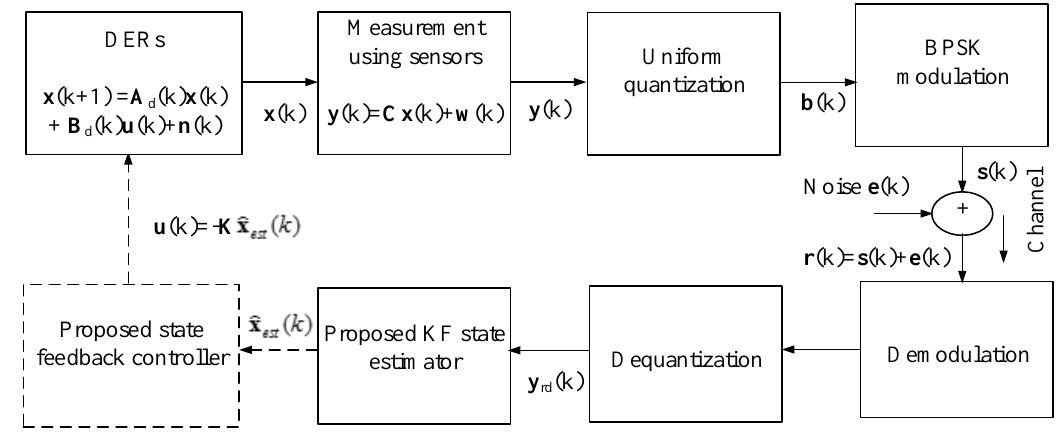
Figure 9. Model for communication systems and dynamic state